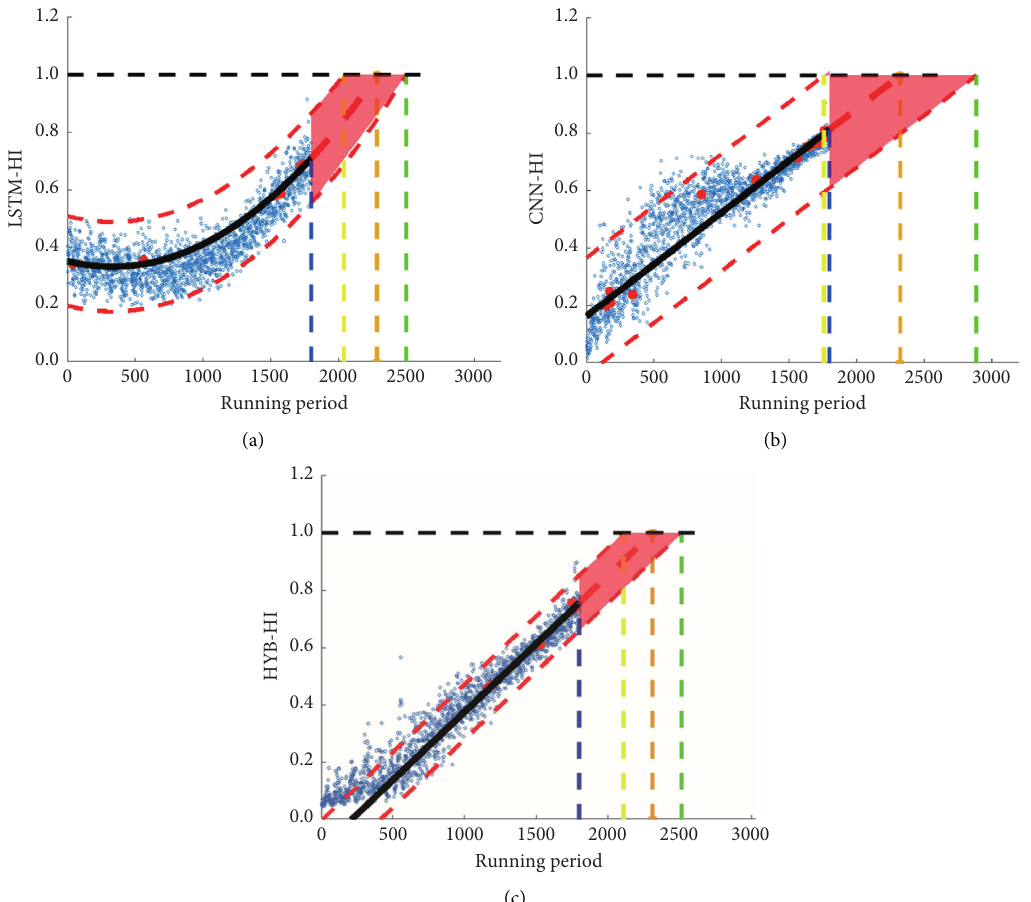
Figure 7: The RUL prediction results of bearing1_3. (a) LSTM-based HI for RUL. (b) CNN-based HI for RUL. (c) Hybrid-structure-based HI for